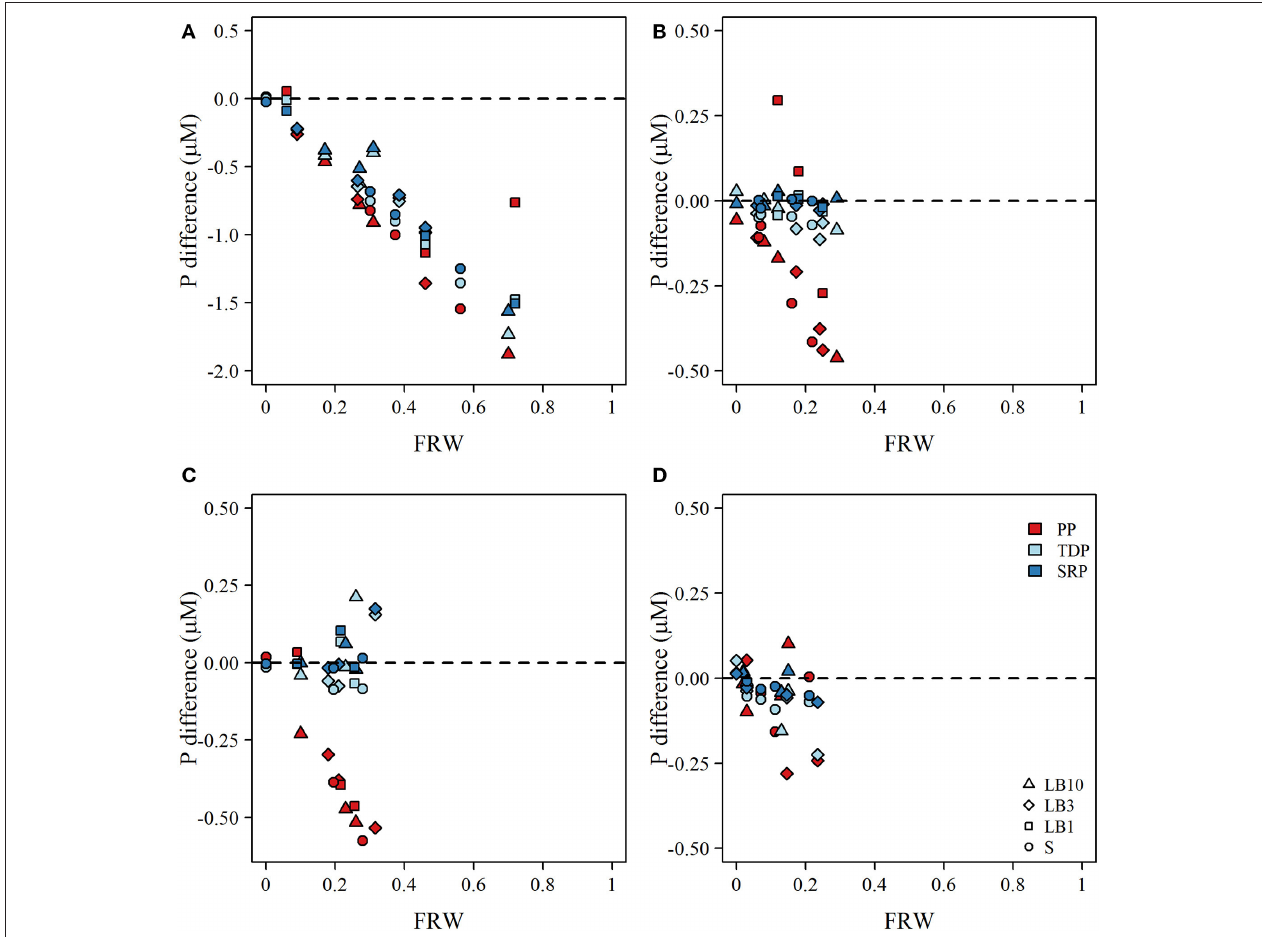
FIGURE 3 | Plot the calculated difference between observed and expected concentrations of particulate P (PP), total dissolved P (TDP), and soluble reactive P (SRP) as a function of the fraction of river water (FRW) at each site for (A) late-May to early-June, (B) June, (C) July, and (D) August. Symbols correspond to surface (S; circles), lakebed 10m (LB10; triangle), lakebed 3m (LB3; diamond), and lakebed 1m (LB1; squares). Dashed line in each panel indicates the difference in concentration that would occur if mixing PP, TDP, and SRP of river and lake water were conservative assuming a two—member mixing model.Expected concentrations were calculated collowing Equation